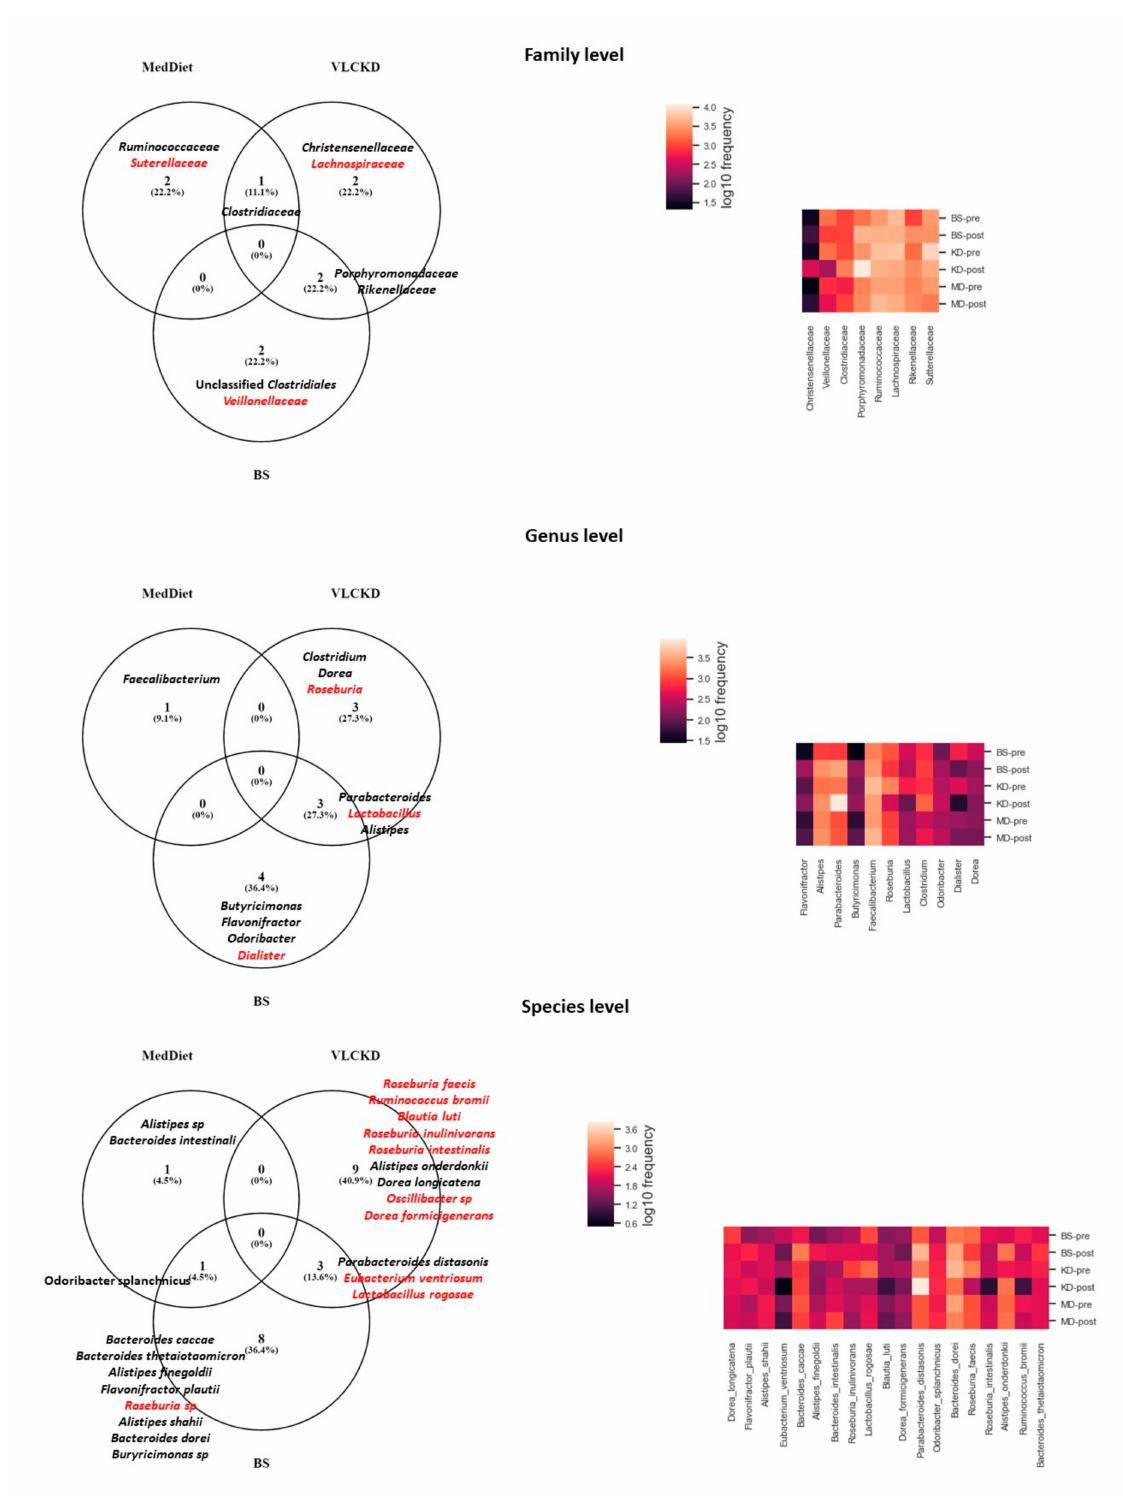
Figure 2. Taxon that changed significantly in each intervention at different taxonomic levels. In red color: taxon that decreased their abundance at the end of the intervention. In black color: taxon that increased their abundance at the end of the intervention. MedDiet: Mediterranean Diet group ( n = 21). BS: Bariatric surgery group ( n = 22). VLCKD: very-low calorie ketogenic diet group ( n =